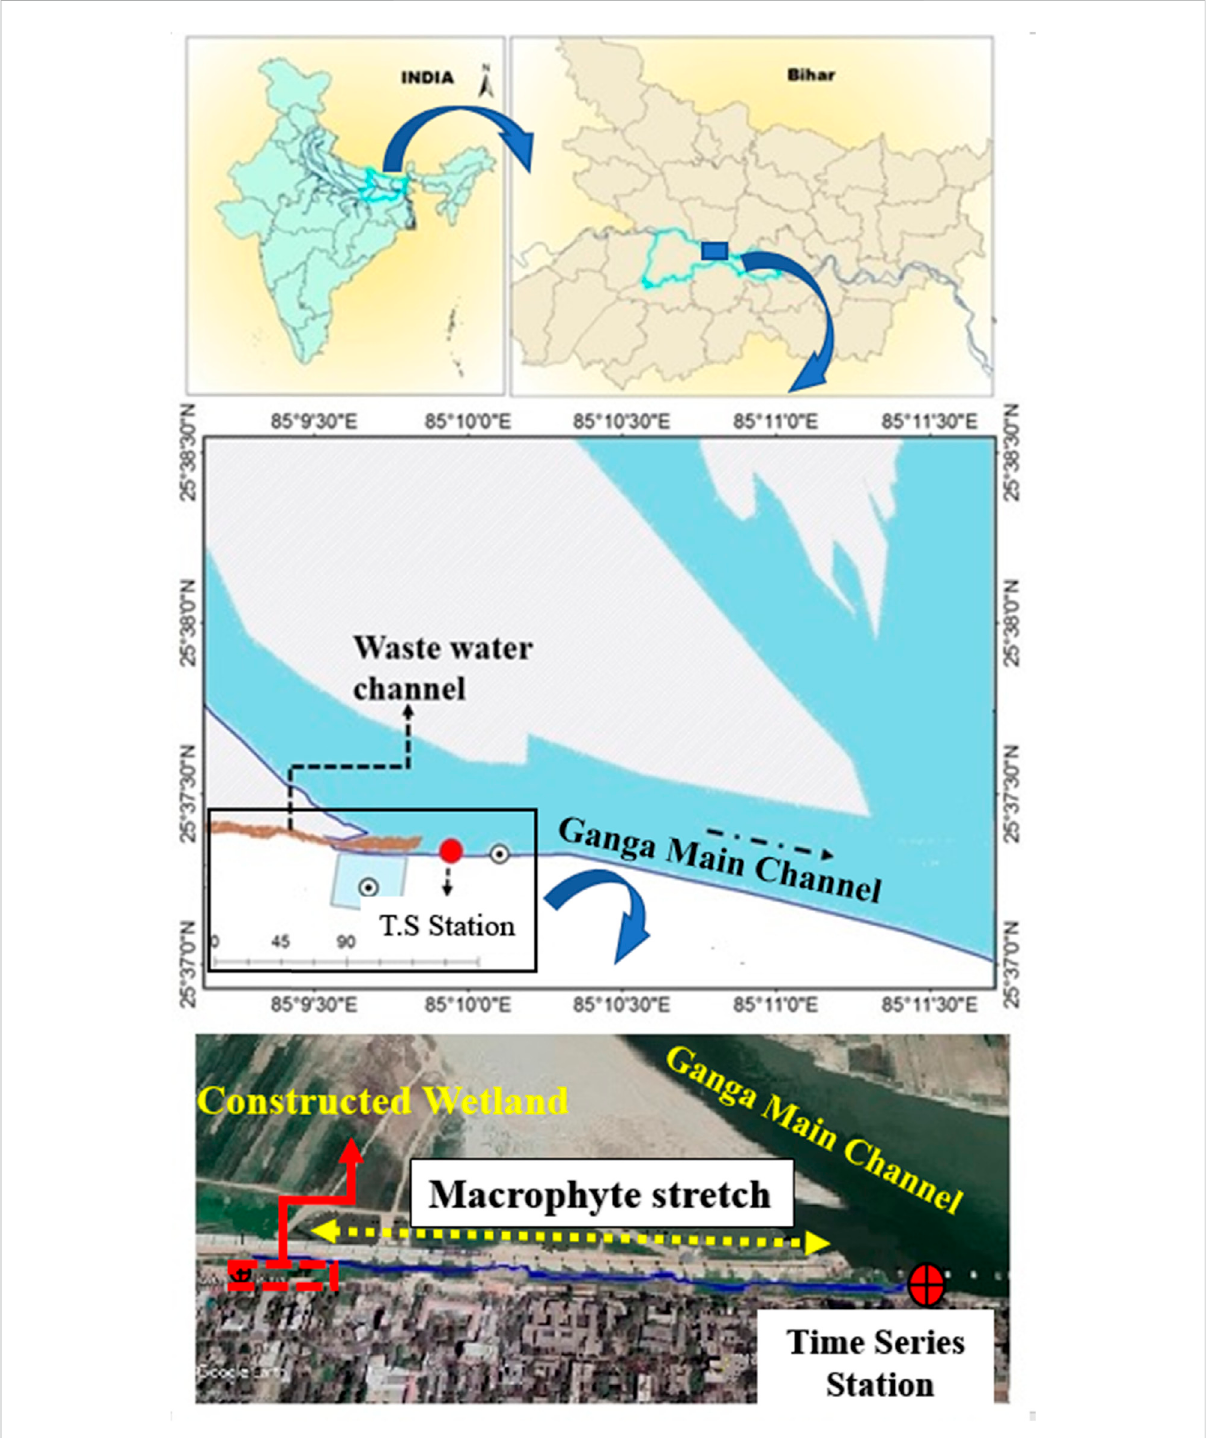
FIGURE 1 Map showing sites of time series study, constructed wetland system (CWS) and fl oodplain between Anatghat and Kalighat for monitoring of